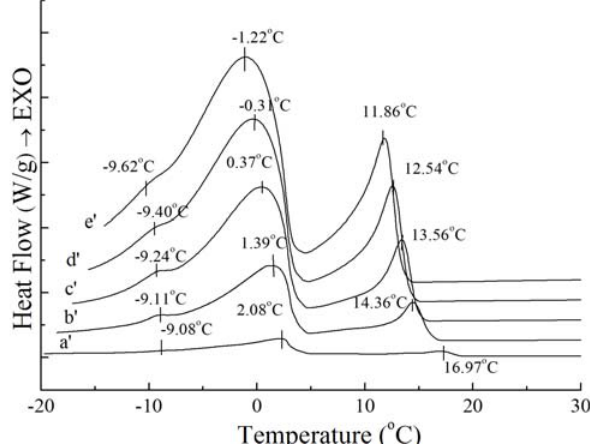
Figure 4. Crystallization curves with different cooling rate of PO: 1 °C/min ( a' ),